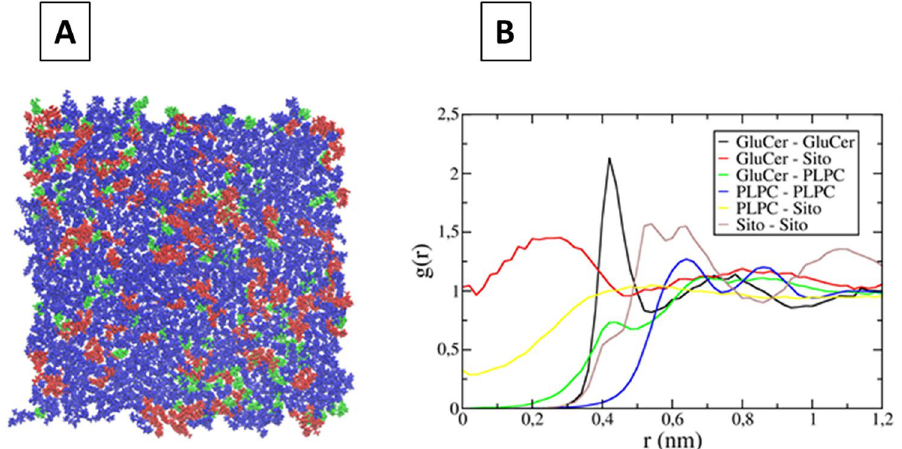
Figure 2. Molecular dynamics simulations on PLPC/sitosterol/GluCer (60/20/20) bilayer. Blue: PLPC, green: sitosterol (Sito) and red: GluCer. ( A ) Top view of the bilayer at the end of the simulation; ( B ) radial distribution of the different lipids in the membrane plane. It represents the probability density (g(r)) to find a lipid species (the second name of the legend) at a certain distance (r) of a defined lipid species (the first name of the legend) along the